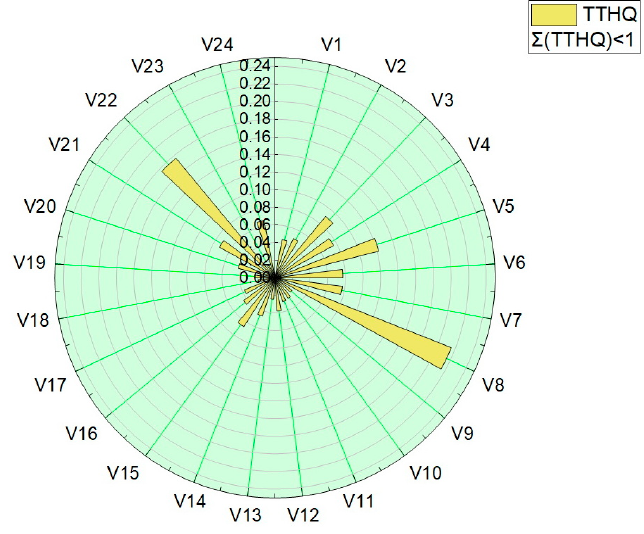
Figure 9. Graphical representation of the sum of the target hazard quotient (TTHQ).